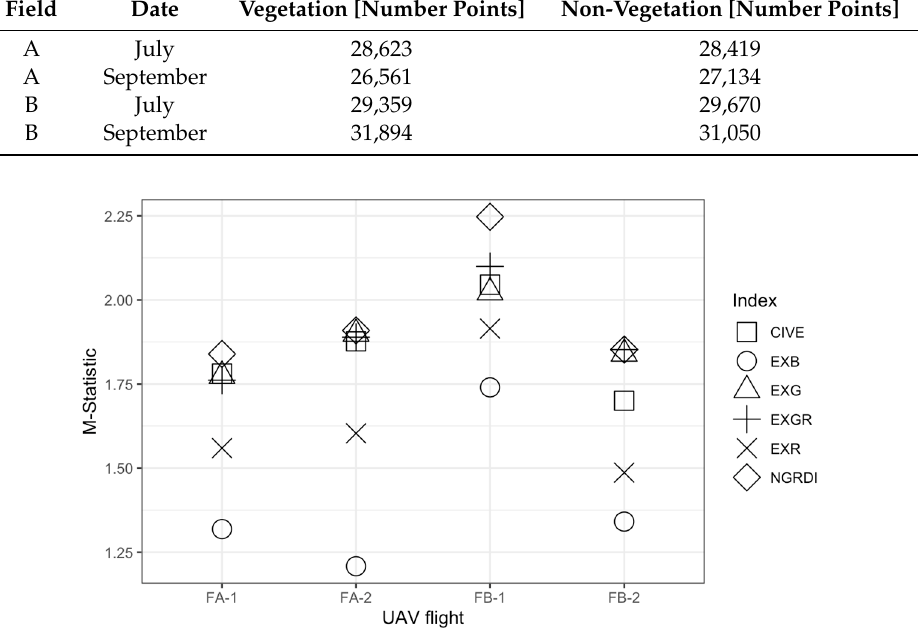
Figure 5. M-Statistic values for each UAV flight per Field (A and B) and month (1: July and 2: September).